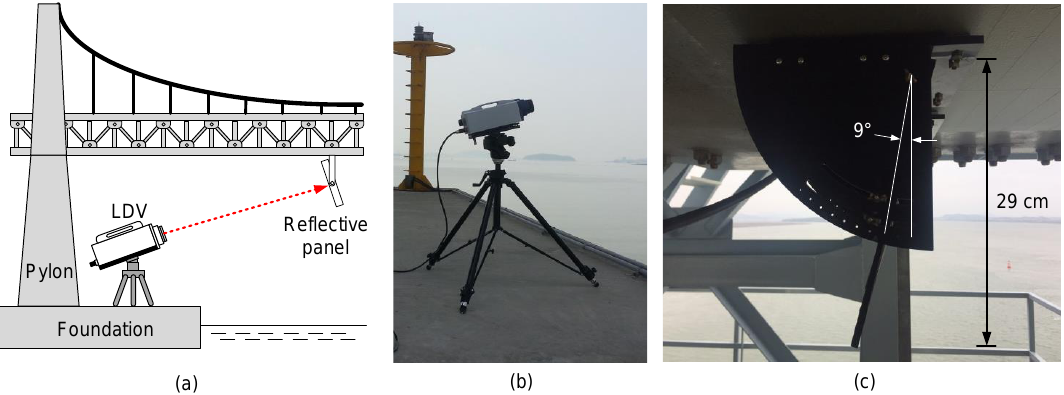
Figure 11. Test setup for the measurement of reference displacement at Yeongjong Grand bridge: ( a ) overall setup diagram of LDV and reflective panel, ( b ) LDV, and ( c ) reflective panel.